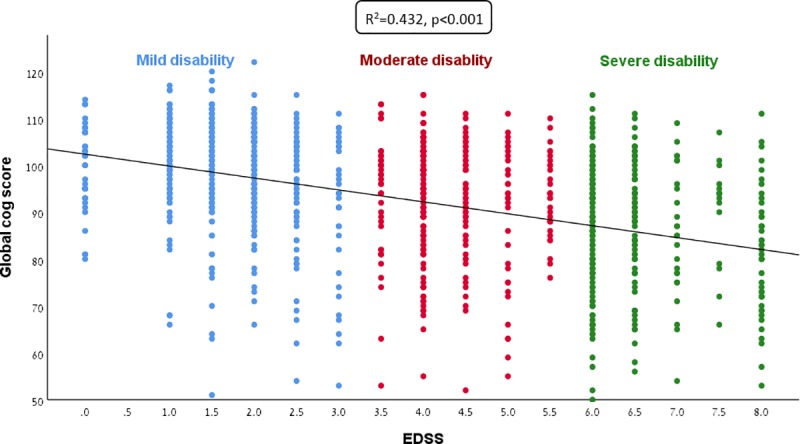
Correlation between cognitive performance and disability.